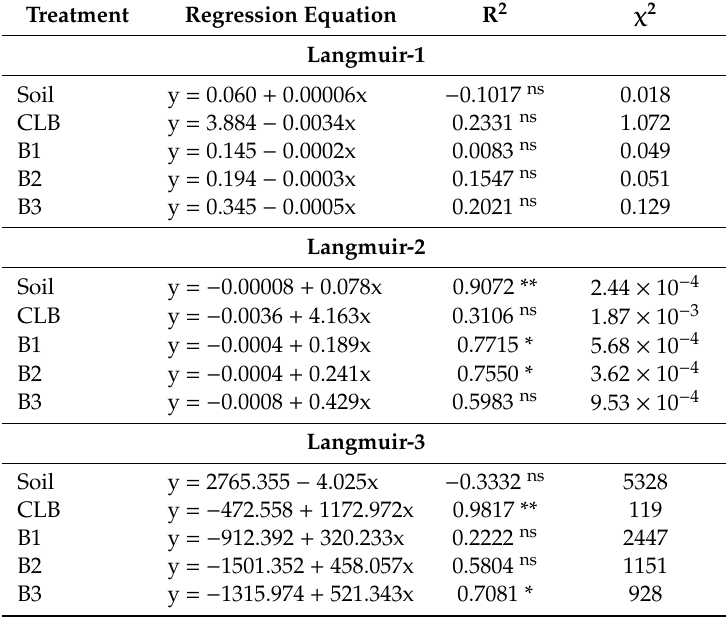
Table 17. Regression equations, Coe ffi cient of determination (R 2 ), and Chi-square analysis ( χ 2 ) for the fit of the Langmuir type 1, 2, and 3 isotherms to the potassium adsorption data of the treatments.